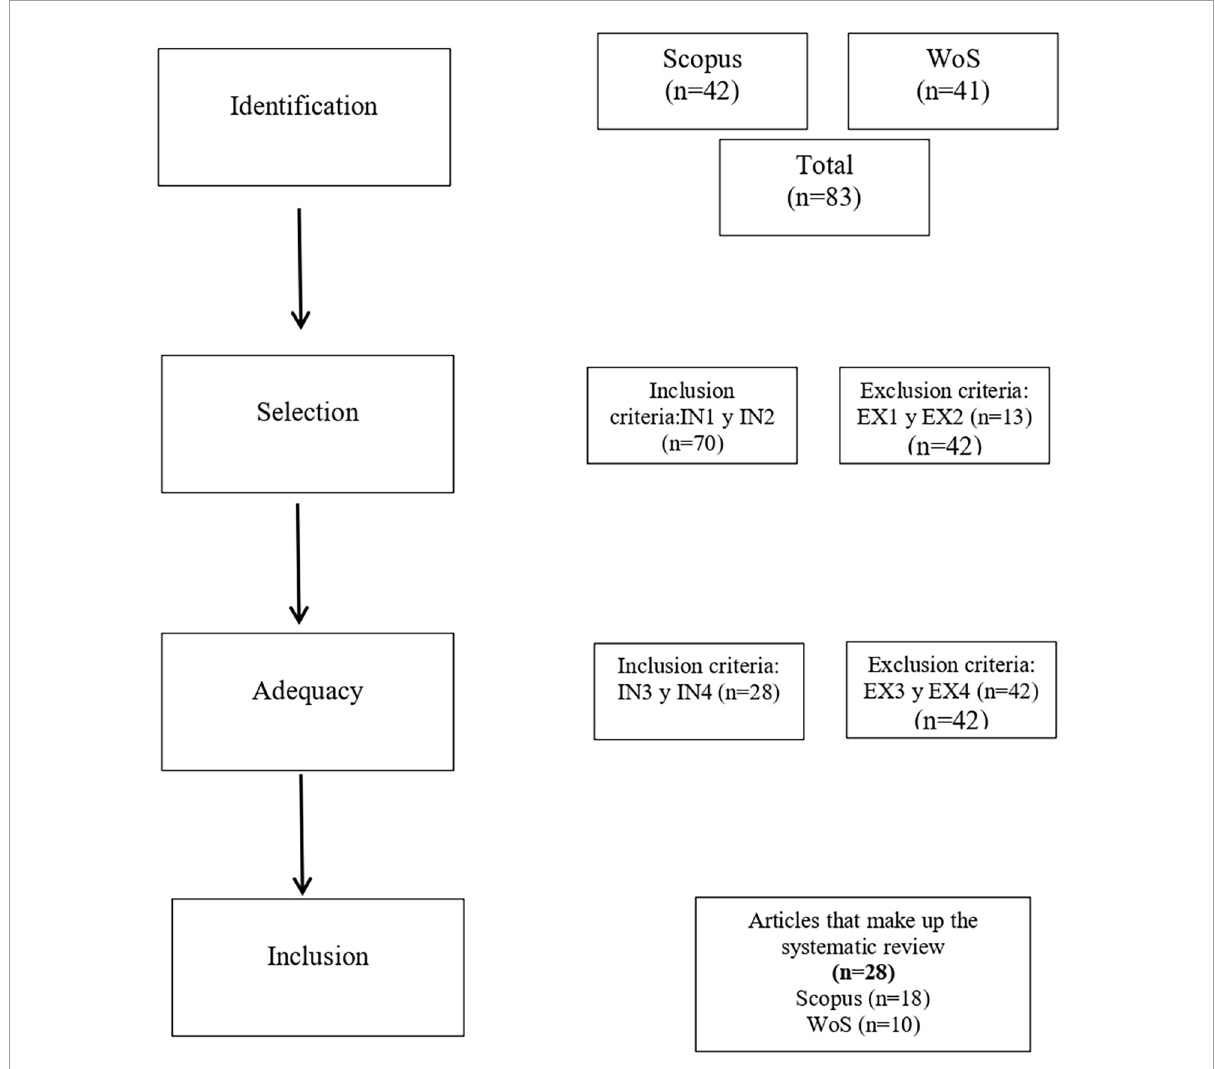
FIGURE2 Flow diagram. Source: own production.